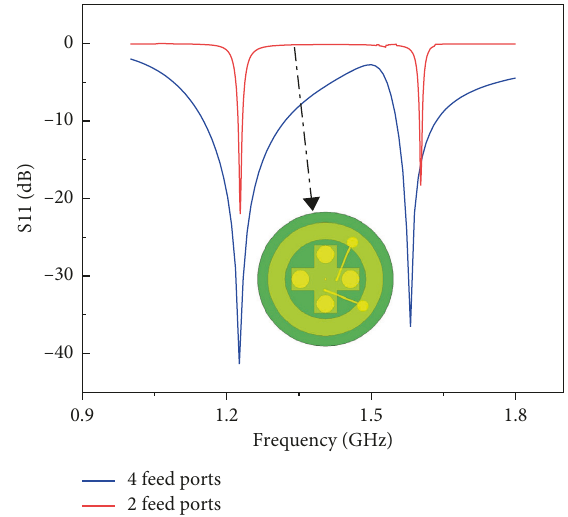
Figure 4: Simulated S11 of two kinds of